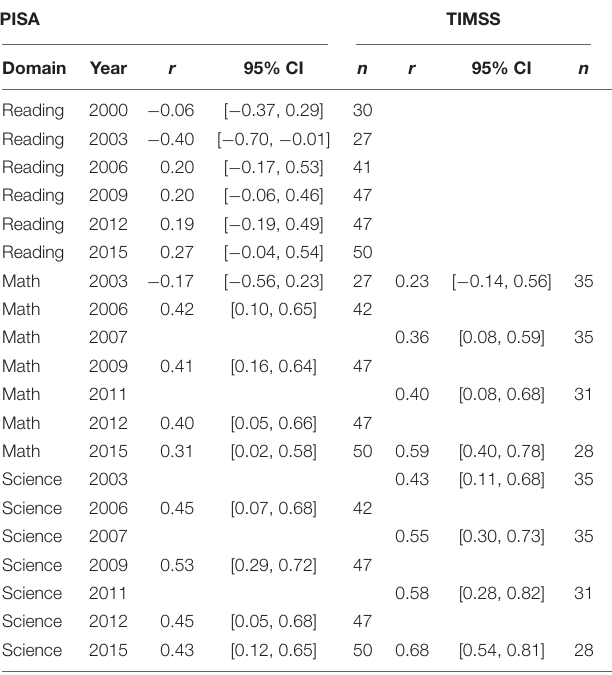
TABLE 2 | Correlations between gender egalitarian values (WVS) and relative mean achievement of boys vs. girls for each wave of PISA and